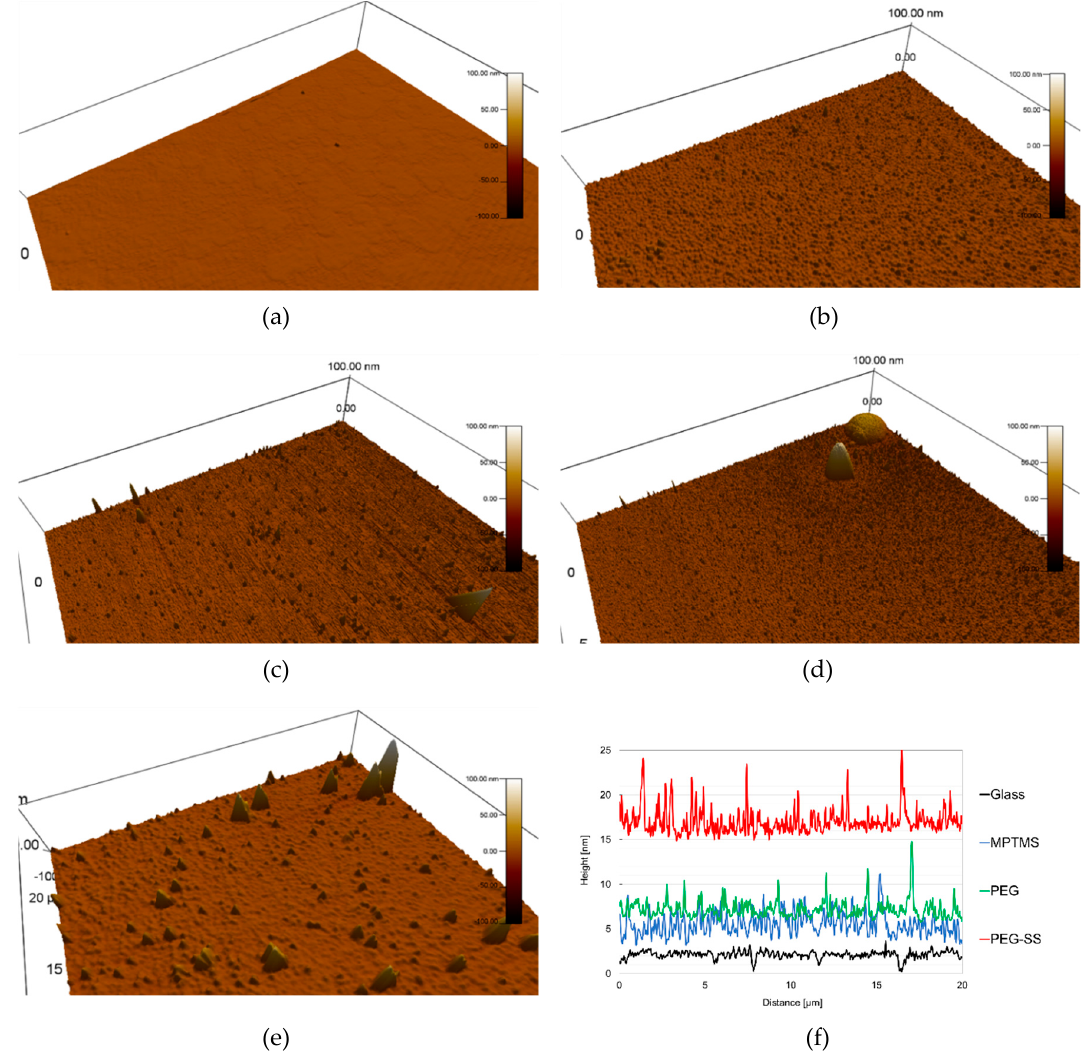
Figure 4. Typical results for surface observation by atomic force microscope (AFM): ( a ) Glass ; ( b ) MPTMS ; ( c ) PEG ; ( d ) PEG-SS ; ( e ) GA-SS ; ( f ) height profiles. Note that the origin of height for the coated surfaces is arbitrary. The standard deviations are 0.44 nm for Glass , 1.28 nm for MPTMS , 0.97 nm for PEG and 1.4 nm for PEG-SS .